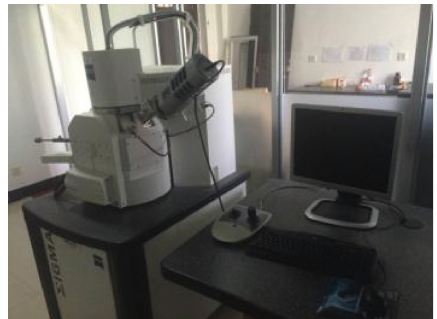
Figure 1: Photo of SEM.